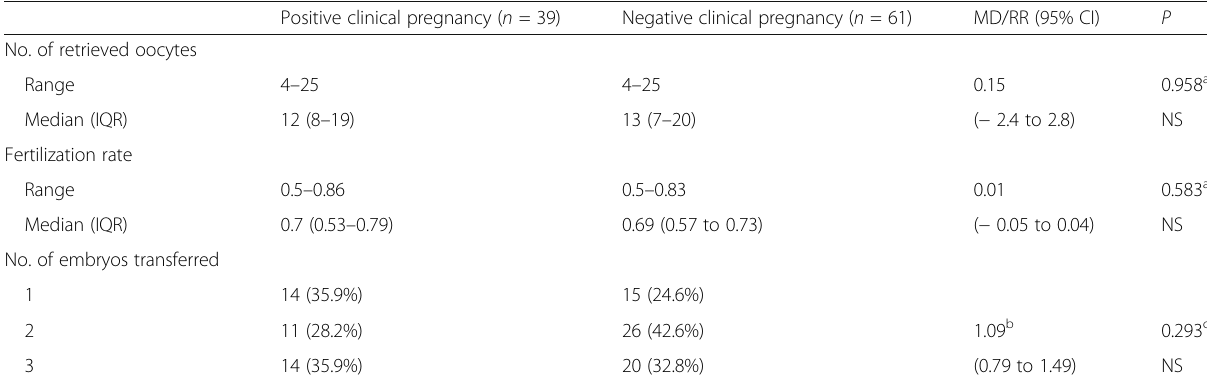
Table 6 Difference between women who had positive clinical pregnancy outcome in repeat IVF/ICSI cycle and women who did not regarding retrieved oocytes, fertilization rat, and embryos